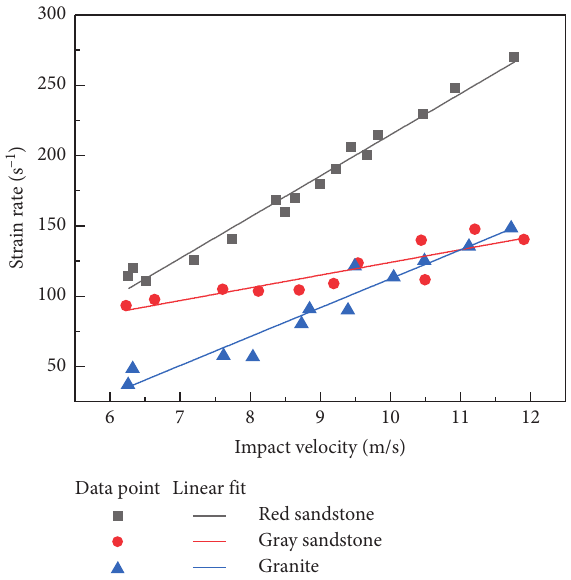
Figure 7: Strain rate-impact velocity diagram.